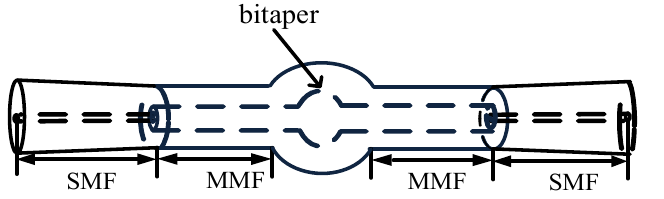
Figure 6. Schematic diagram of the Etched Single mode–Multimode–Bitaper–Multimode–Single mode Mach–Zehnder Interferometer (ESMBMS MZI).